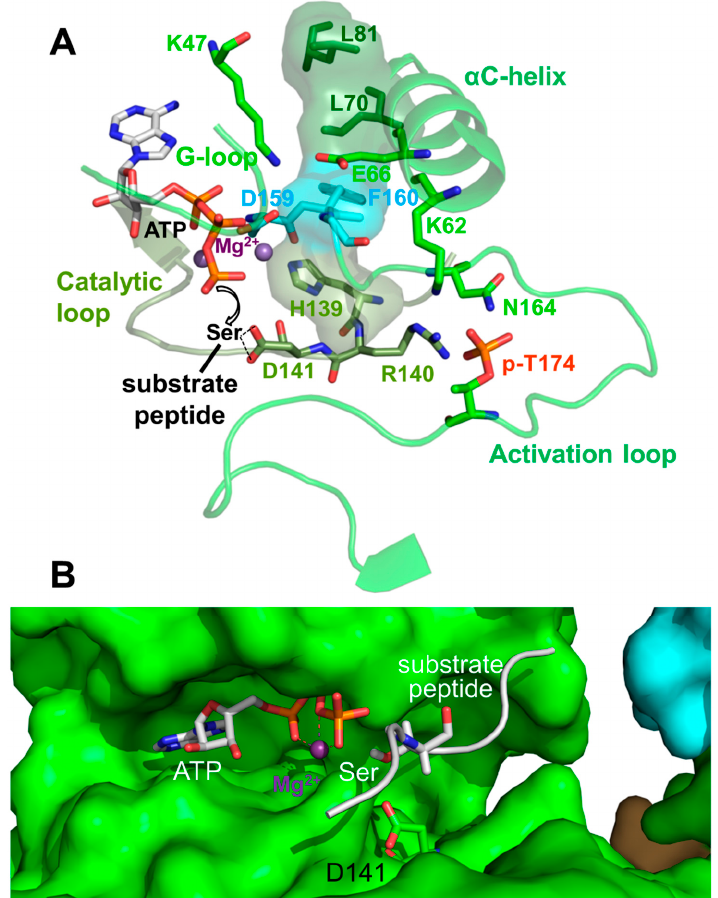
Figure 3. Active protein kinase catalytic cleft. ( A ) Key residues and structural elements of